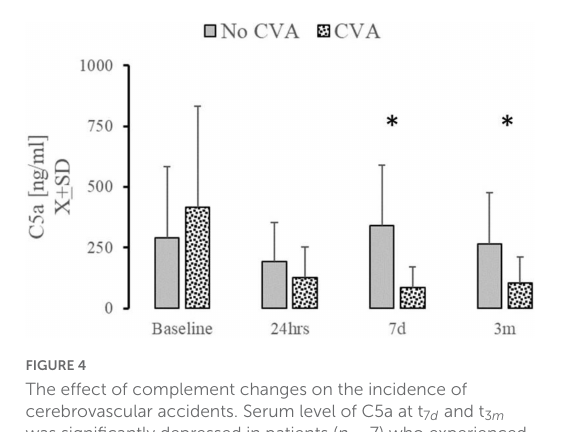
FIGURE4 The effect of complement changes on the incidence of cerebrovascular accidents. Serum level of C5a at t 7 d and t 3 m was significantly depressed in patients ( n = 7) who experienced stroke during 28 days after surgery. *Denotes the statistical significance of 0.05 or